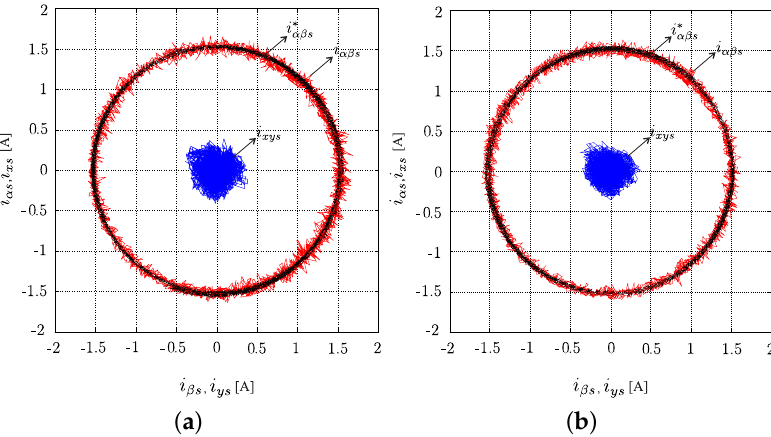
Figure 7. Experimental results in the ( α - β )-( x - y ) frame for stator currents at 8 kHz of sampling frequency and 500 rpm rotor speed considering: ( a ) λ xy = 0.05; ( b ) λ xy =